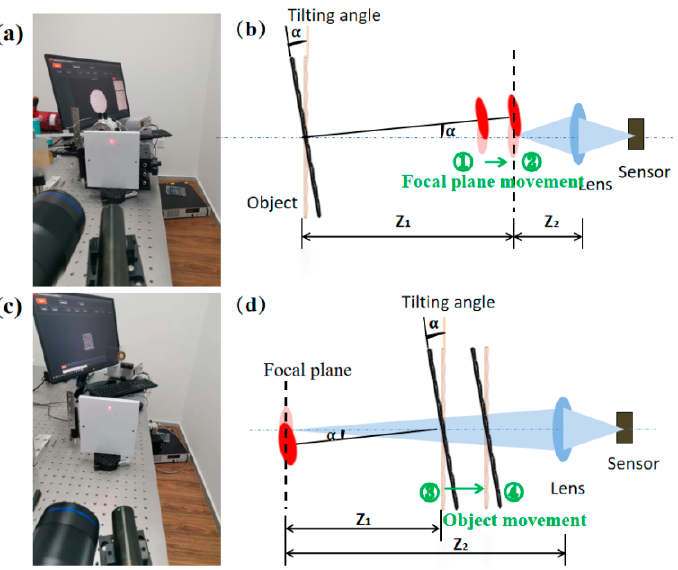
Figure 14. ( a ) Physical and ( b ) schematic diagrams of the first two experiments. ( c ) Physical and ( d ) schematic diagrams of the last two experiments.